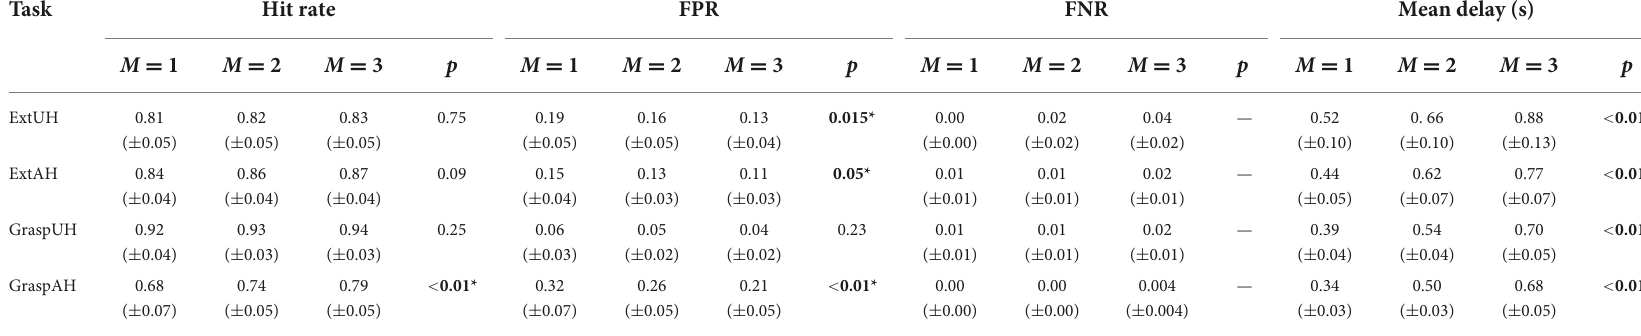
Performances are obtained considering different number M of consecutive sliding windows tested as accumulation before a final classification decision. The fourth column of each parameter reports the p -value of the rmANOVA considering M as within factor.Boldvaluesflankedbyasterisks(*)indicatesignificantdifferences p <